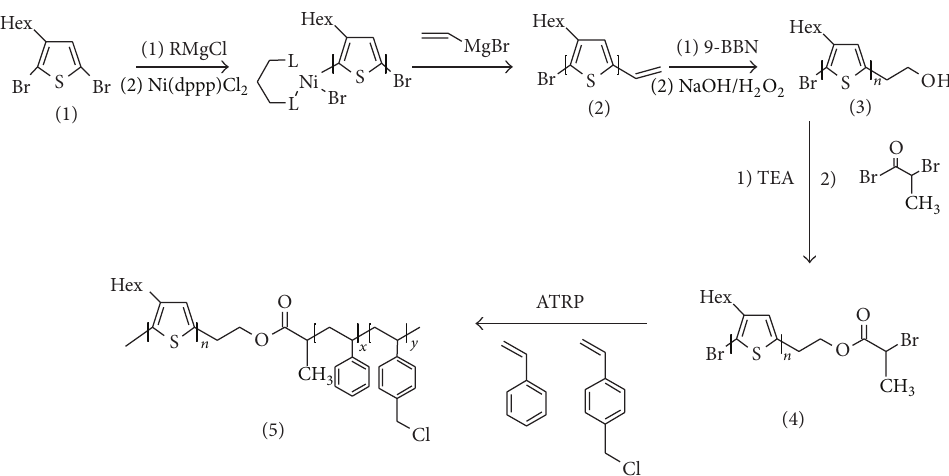
Figure 1: Schematic draw illustrating a synthetic route for preparing P3HT- b -P(S- co -CMS) via atom transfer radical polymerisation (ATRP).